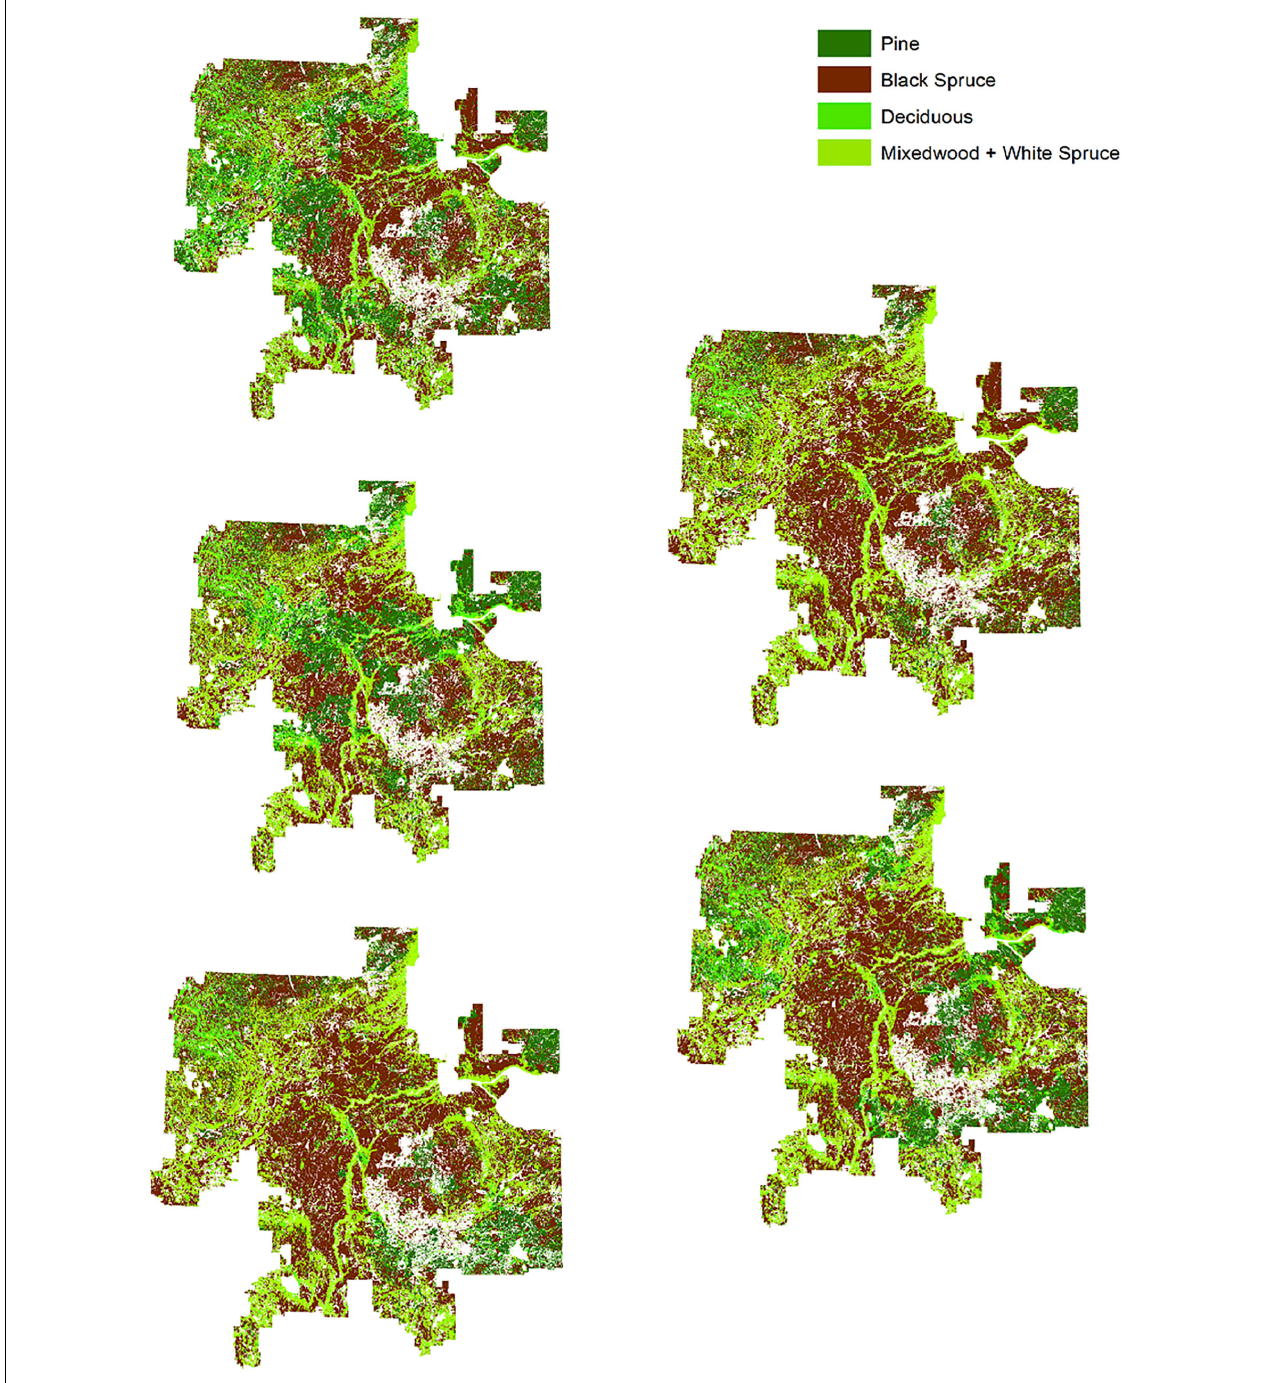
FIGURE 3 | Examples of “snapshots” of forest age-structure the Al-Pac FMA from simulations of natural disturbance (a 63.5-year fire cycle) in the total absence of human footprint (NRV scenario). In this program, younger forest stands resulted from fires which were also used to replace human footprint over 1000 years of simulated time. We ran this simulation for 1000 years, then used 100 “snapshots” from the simulation to estimate natural range of variation (NRV) of different forest stands and ages. Pure stands of white spruce were not included in the simulation due to their rarity in the Al-Pac FMA. In contrast to the NRV scenario, harvest was the only source of disturbance setting back forest stand age to 0 in the Patchworks scenario and given the small amount of each forest management unit harvested over 50 years in the Patchworks scenarios, forest age on average increased within individual FMUs over 50 years.